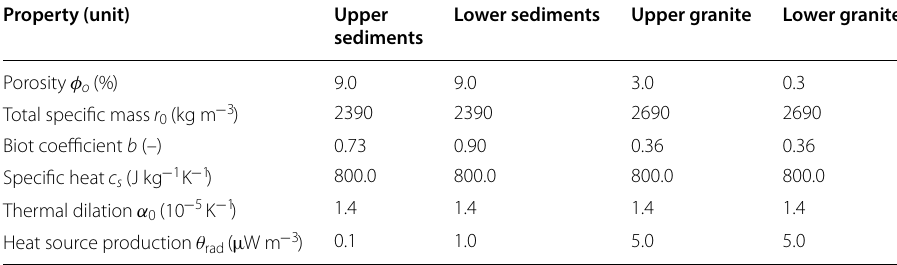
Lower sediments Upper granite sediments